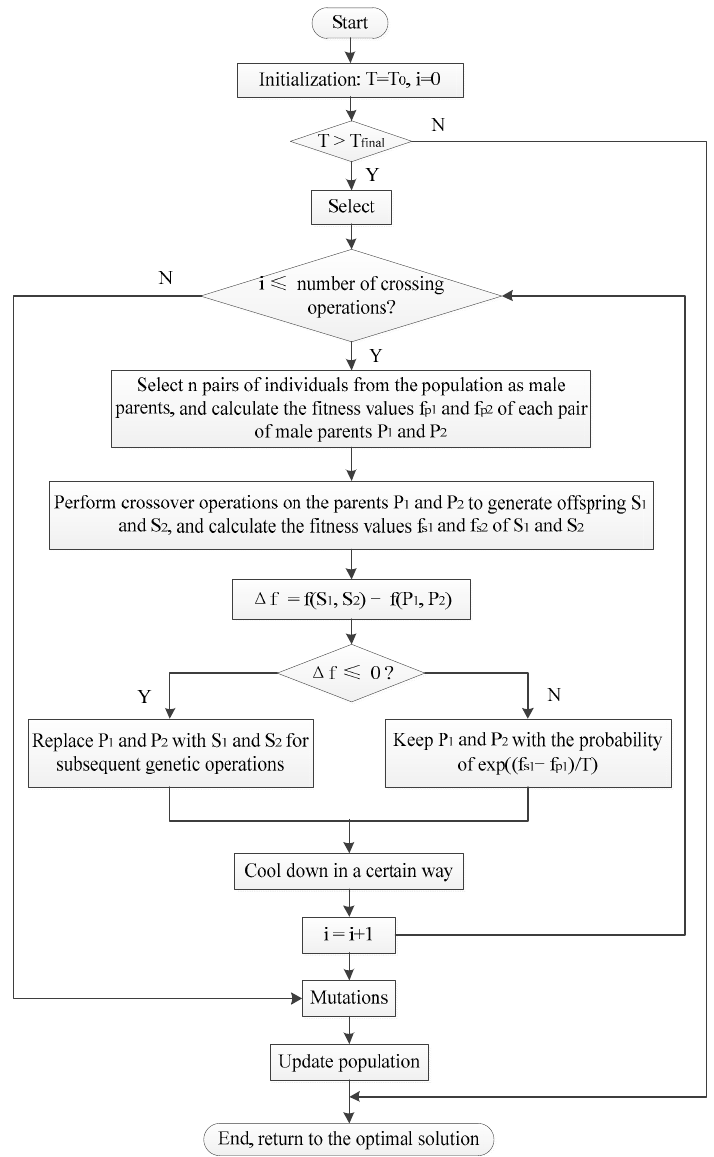
Figure 8. Simulated annealing algorithm flow chart.